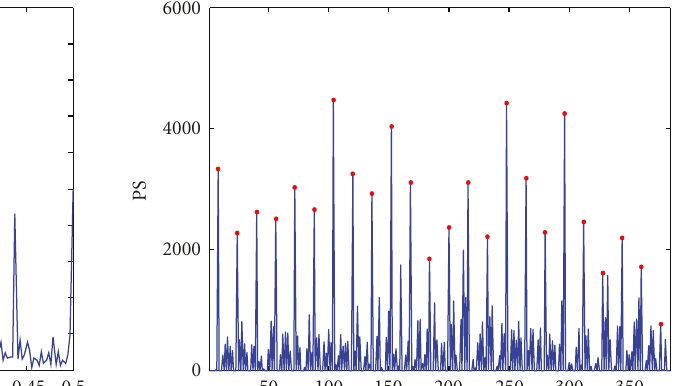
(d) Blocking grid detected from the displayed image in (a) along the horizontal direction Figure 2: Blocking grid detection: an example.